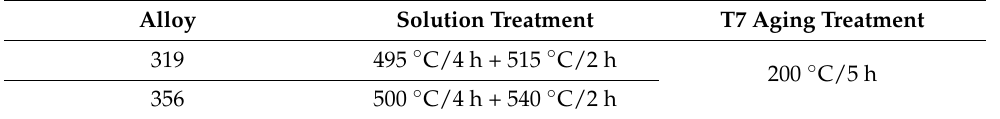
Table 2. Heat treatment parameters for the